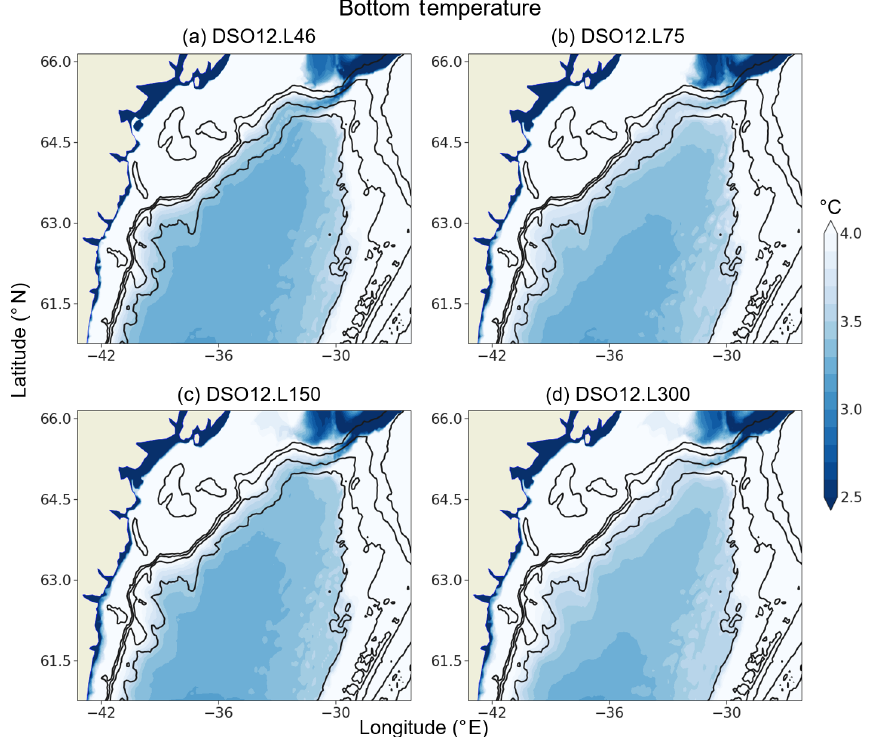
Figure 8. Annual mean bottom temperature (fifth year of simulation; ◦ C) at 1 / 12 ◦ horizontal resolution in simulations with differing numbers of vertical levels: (a) 46 levels (DSO12.L46), (b) 75 levels (DSO12.L75), (c) 150 levels (DSO12.L150), and (d) 300 levels (DSO12.L300). Isobaths 500, 1000, 1500, and 2000m are contoured in black.